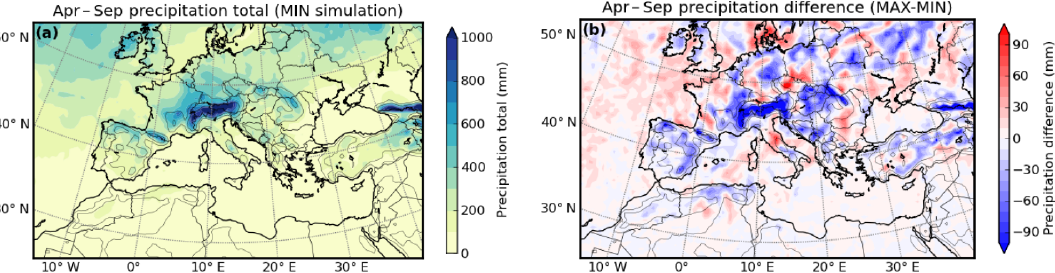
Figure 2. Accumulated precipitation (April–September 2013) from the MIN simulation (a) and difference between MAX and MIN simula- tions of accumulated precipitation (b) .